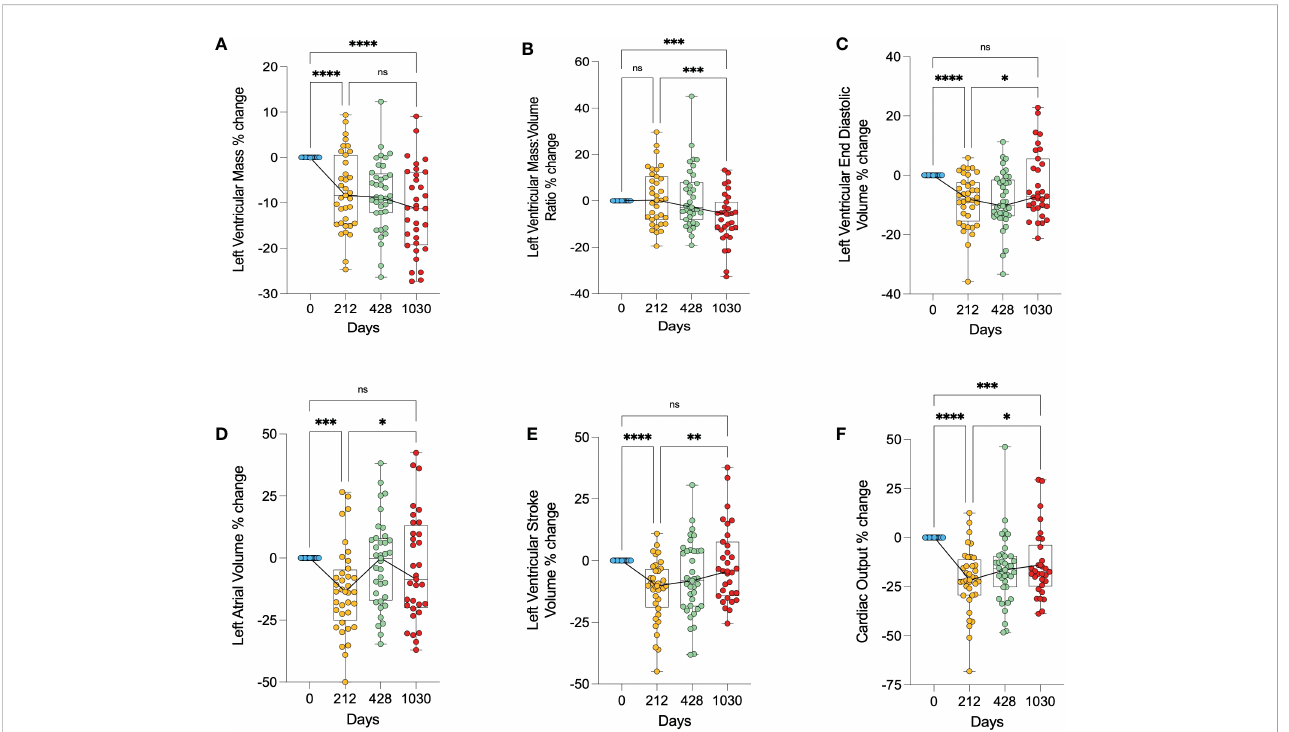
FIGURE 3 Changes in cardiac geometry following bariatric surgery. (A) – percentage change in left ventricular mass, (B) – percentage change in left ventricular mass:volume ratio, (C) – percentage change in left ventricular end diastolic volume, (D) – percentage change in left atrial volume, (E) – percentage change in left ventricular stroke volume, (F) – percentage change in cardiac output. * < 0.05, ** < 0.01, ***<0.001, ****<0.0001, ns, Non signi fi